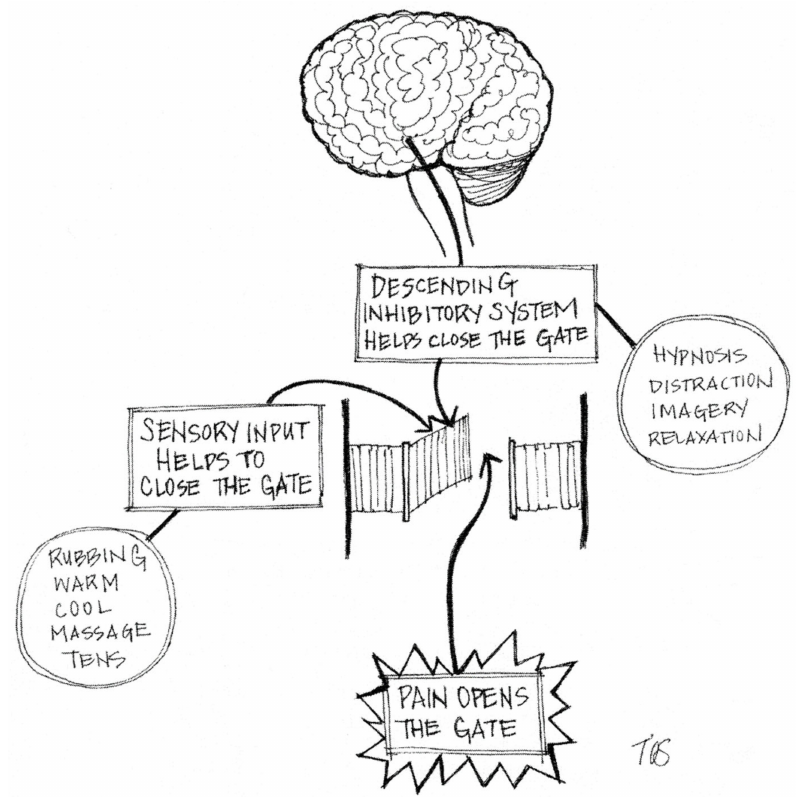
Figure 3. The pain gate [81], based on Wall and Melzack, 2008 [82]. © Leora Kuttner [81], used with